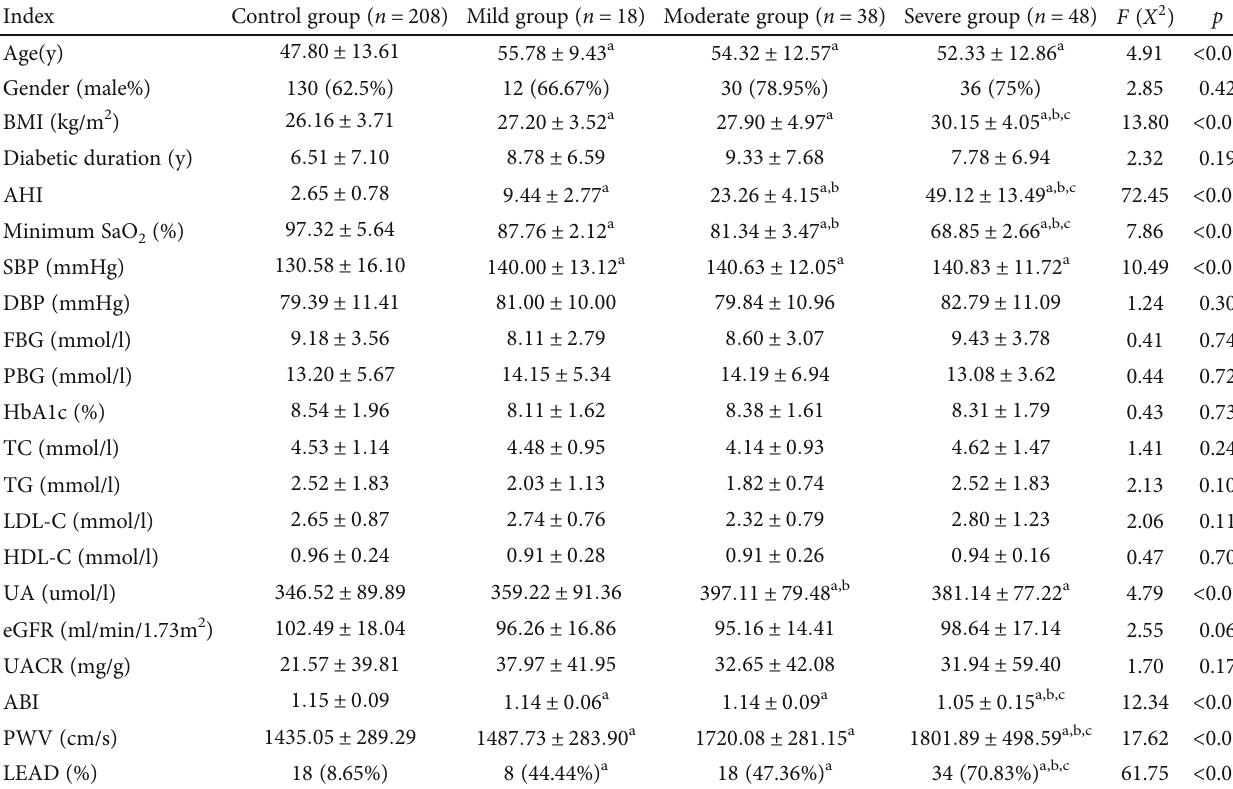
Table 1: Comparison of general characteristics, biochemical indices, PSG indices, and atherosclerosis indices among the four groups.